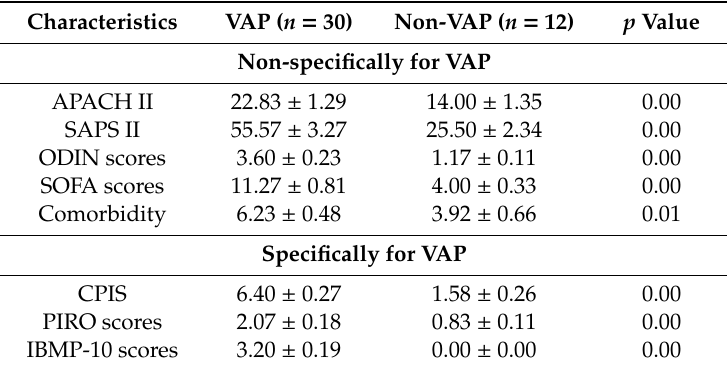
Table 2. Clinical scores of patients with VAP and non-VAP